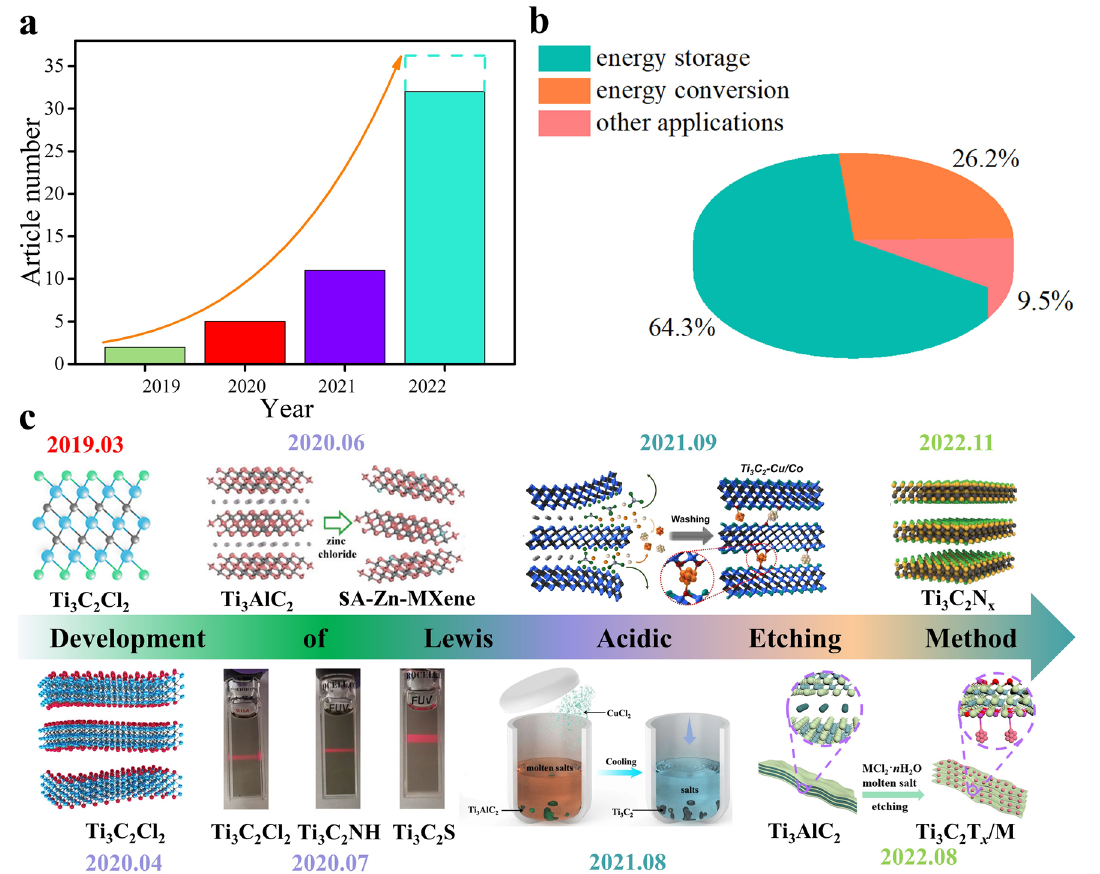
Fig. 3 a Annual publications of Lewis acidic etching method. b Application ratio of MXenes and MXene-based composites prepared by Lewis acidic etching route in different fields. c A timeline showing the development progress of Lewis acidic etching route. Image published